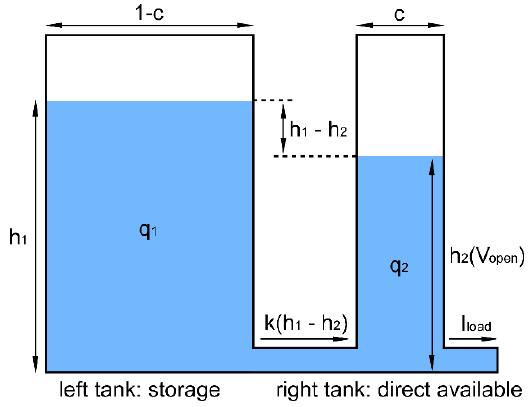
Figure 2. Schematic of the kinetic battery model (KiBaM). The charge can flow from left tank to right tank due to the height difference, h 1 – h 2 .